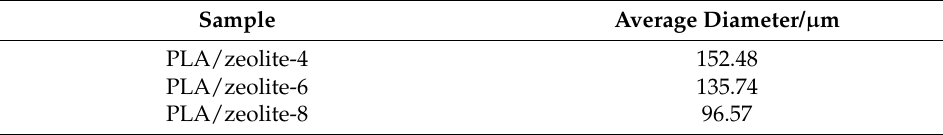
Table 3. The average diameter of spherulites with different zeolite proportions.